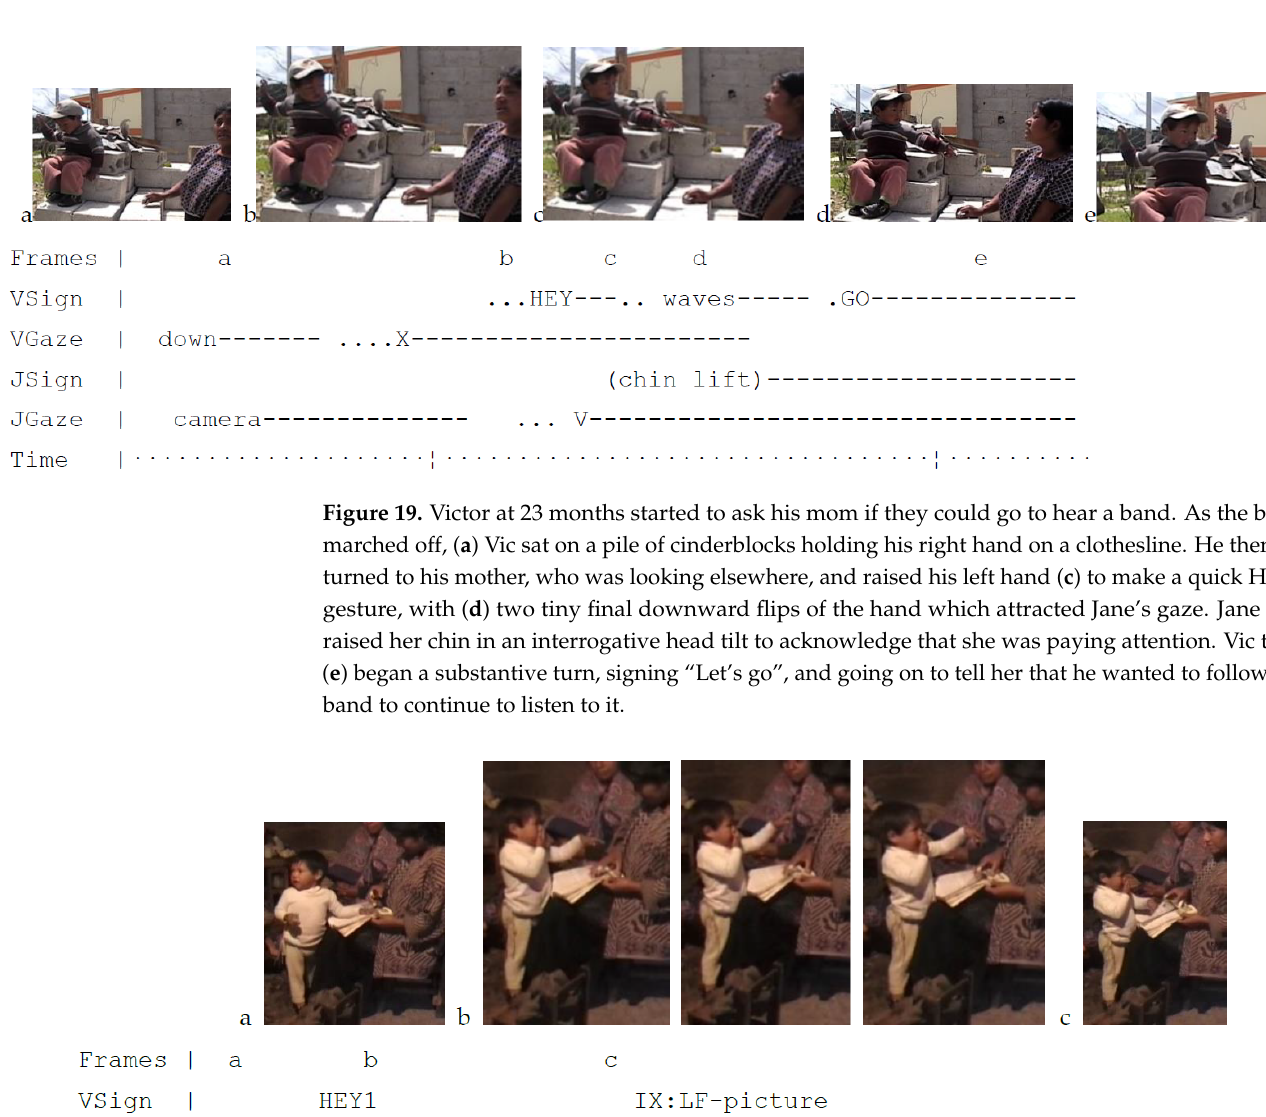
Figure 20. Vic at 24 mos. was told “ask your mom what it’s called”. ( a ) Vic looked away from his cousin as she spoke to him, turned to his mother, who was looking down at the book, raised his left hand so that it passed through her line of sight, and ( b ) did a quick HEY1 with downward flip of the fingers, before ( c ) touching the chosen picture on the page.